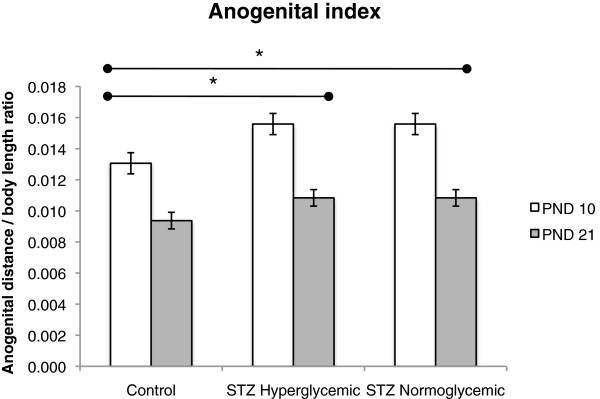
Anogenital index of Control (n = 10), STZ hyperglycemic (n = 6), and STZ normoglycemic (n = 6) rats. Values expressed as mean ± standard error of mean. Significant time effect, p < .0001, significant group effect, p < .05, and significant group and time interaction, p < .05. *p < 0.05 – statistically significant difference compared to Control group (ANOVA followed by Tukey’s test).